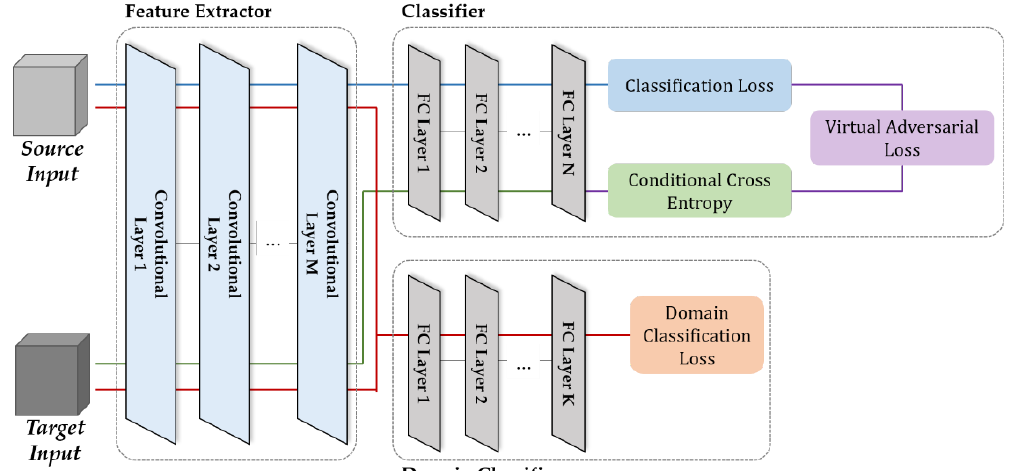
Figure 6. The architecture of Decision-boundary Iterative Refinement Training with a Teacher (DIRT-T) domain adaptation.